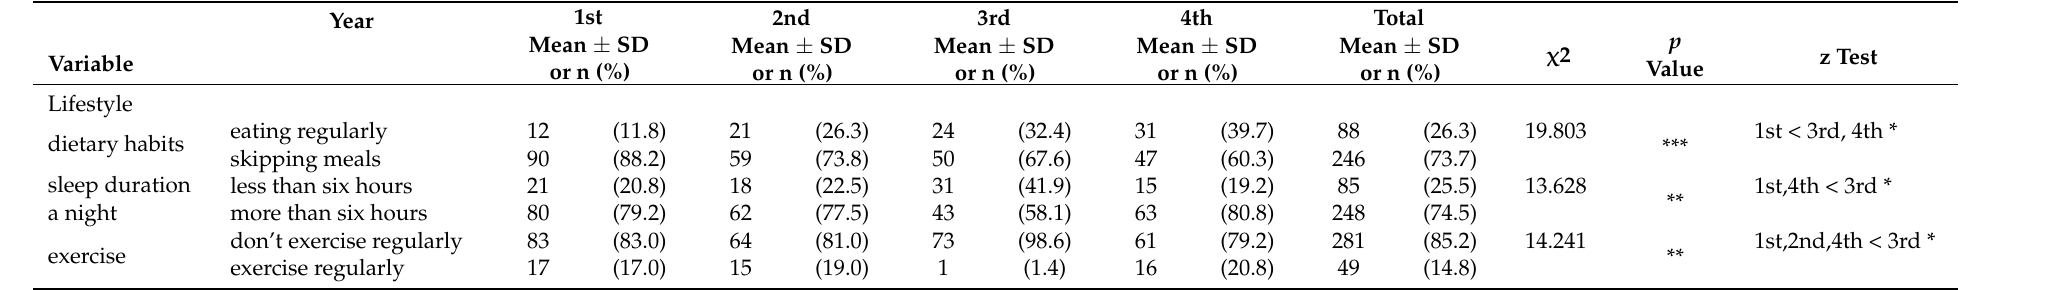
Table 2. Association between students of each year and lifestyle of students (N =